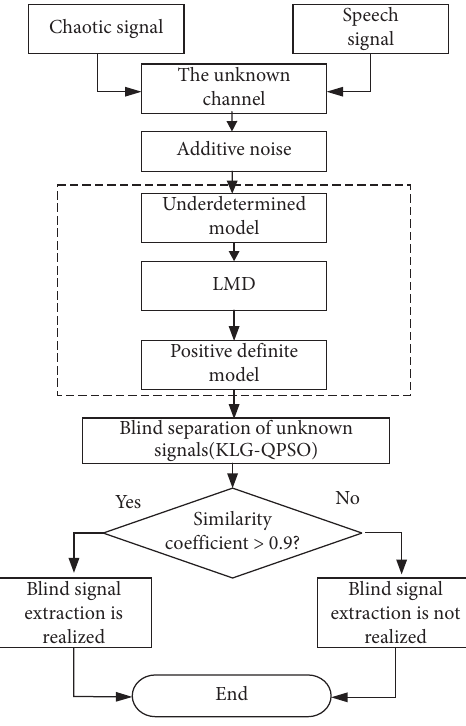
Figure 10: Simulation flow